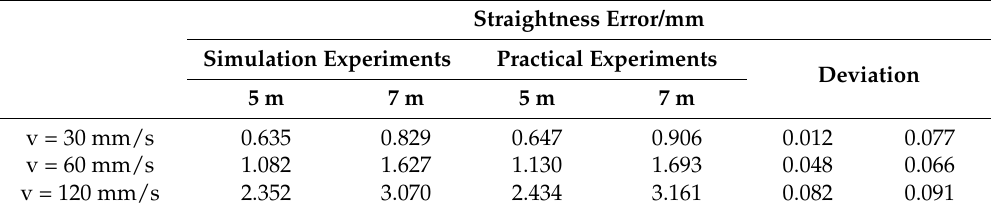
Table 1. Deviation between simulation and practical experiments.